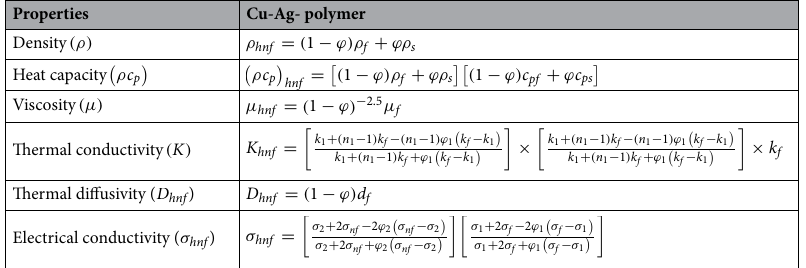
Table 1. Correlation among hybrid nanostructures and nanomaterials in polymers.